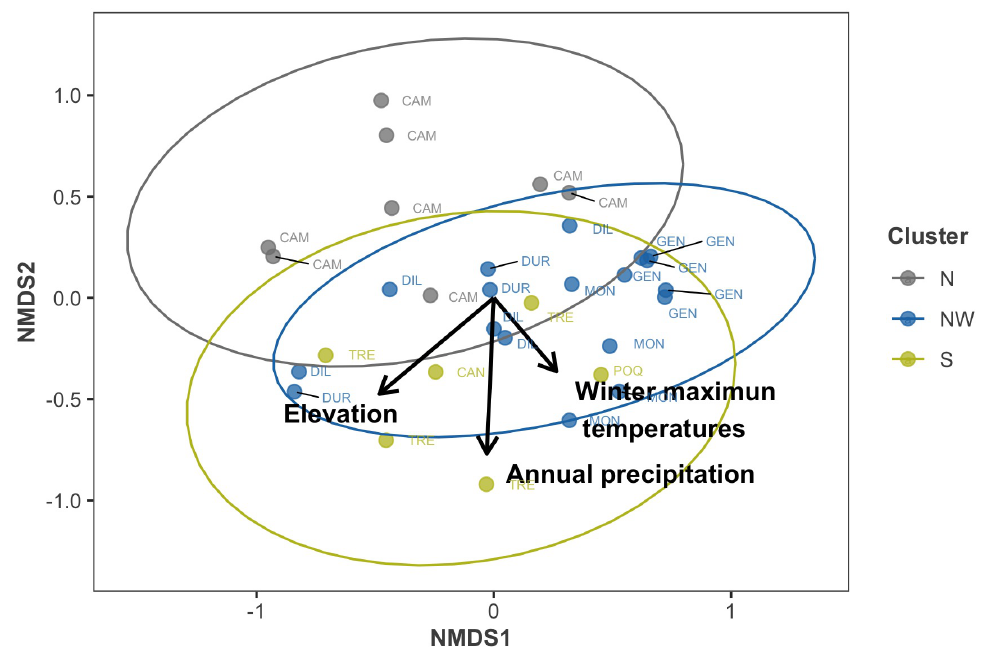
Figure 4. NMDS ordination of the plots. Points represent plot sites displayed according to their similarity in species composition. Proximity in the statistical space indicates plot sites with a similar species composition. Arrows represent vectors of significantly environmental variables explaining the ordination (see Table 5). Each plot was colored according to the three oak-populations’ clusters derived from discriminant analysis. Only two dimensions of the NMDS are illustrated for ease of representation.